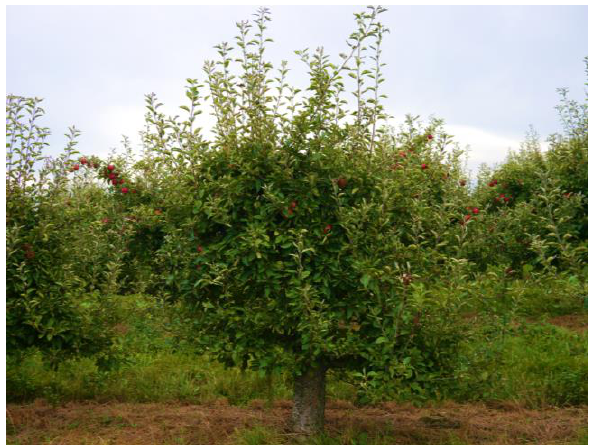
Figure 1. An apple tree in the test orchard